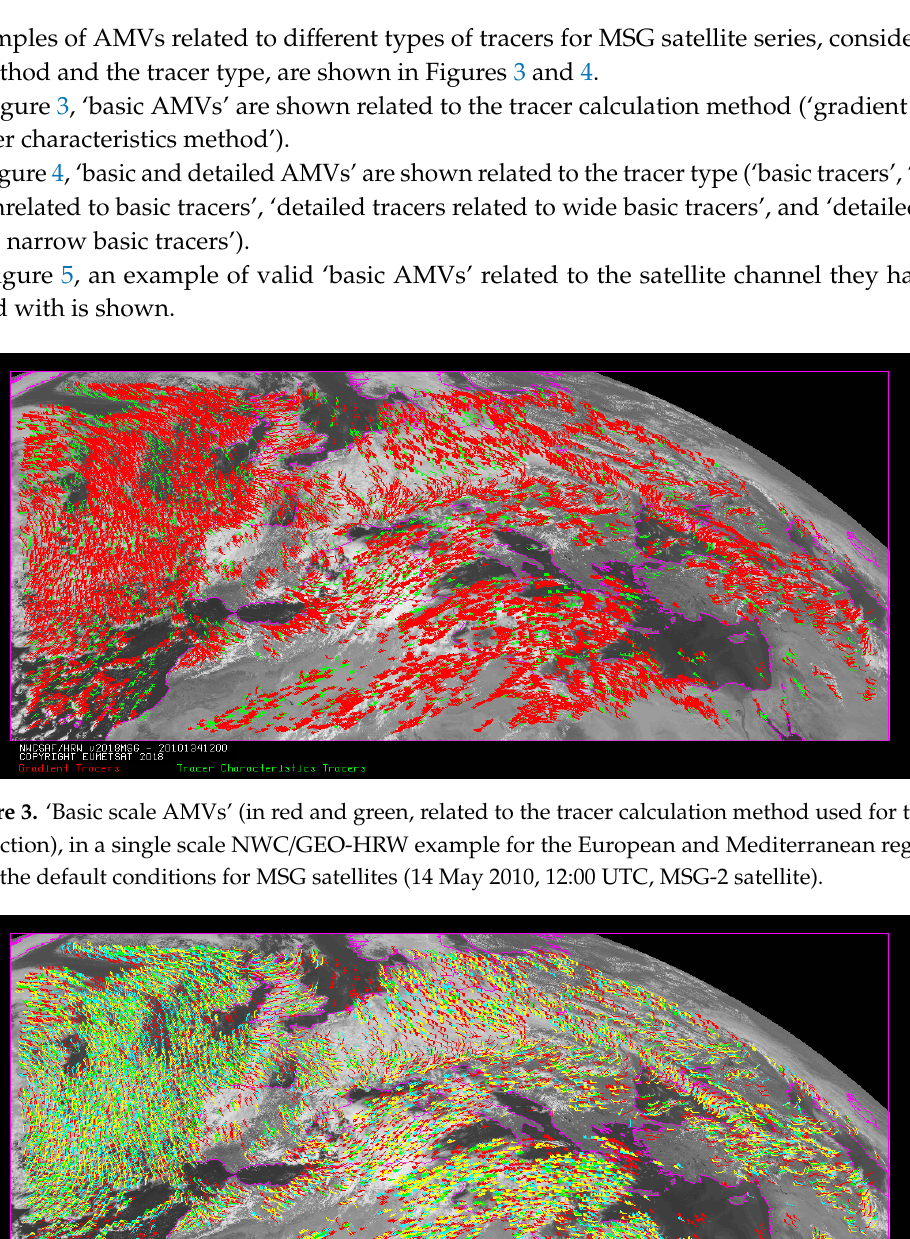
Figure 4. ‘Basic scale AMVs’ (in red), and ‘detailed scale AMVs’ (in yellow, green, and blue, considering their relationship with the basic scale AMVs), in a two-scale NWC/GEO-HRW example for the European and Mediterranean region, with the default conditions for MSG satellites (14 May 2010, 12:00 UTC, MSG-2 satellite).